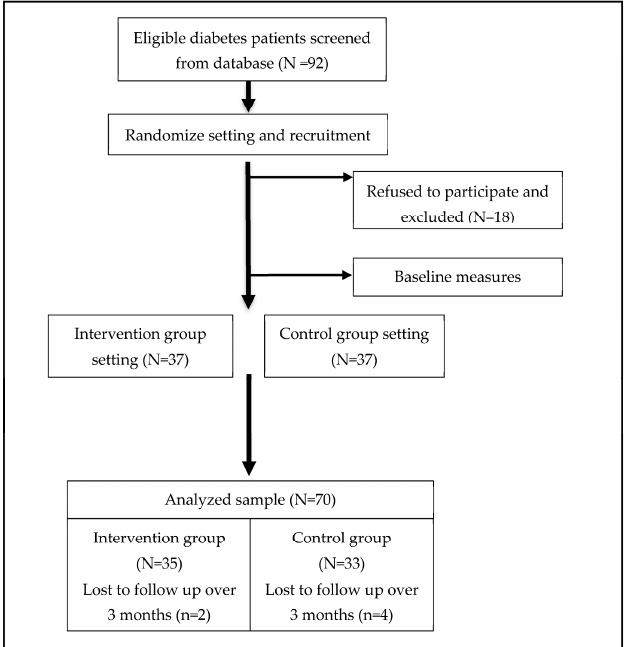
Figure 1. Flow diagram of participants: recruitment, intervention and follow-up.